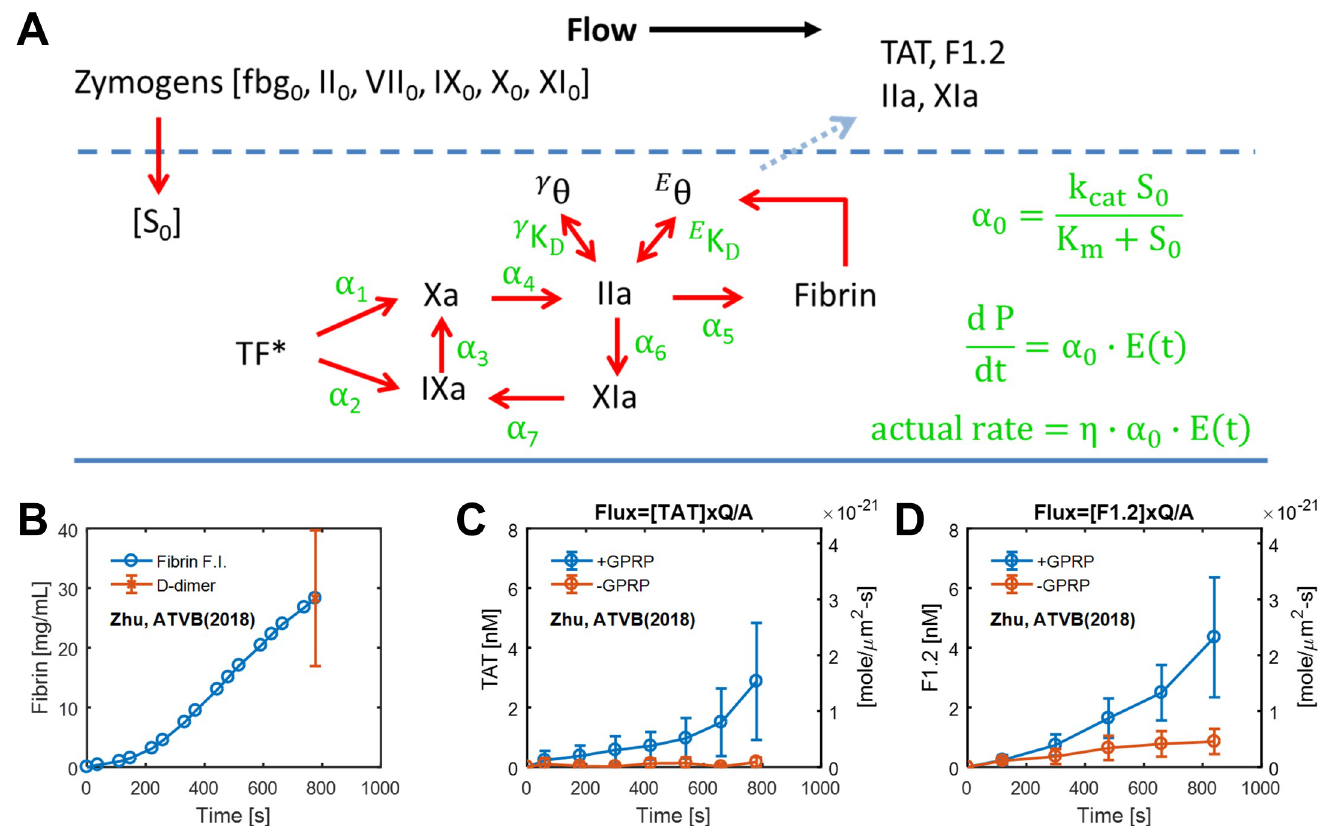
Fig 1. Schematic of the reduced model. With 7 reactions, only the activated proteases are shown (A). All zymogens were assumed to enter the clot core by diffusion to maintain their plasma level [S] o . All active enzymes had a 1-minute half-life, with TF � set to 3 min. Elution rate from the core was set to 2-sec half-life. The dynamic of fibrin from 8-channel device of the fibrin fluorescence intensity with the end-point concentration determined by D-dimer ELISA (B). Thrombin flux from the collagen/TF surface determined by thrombin-antithrombin complex (TAT) ELISA with and without GPRP to allow fibrin formation (C). Thrombin flux from the collagen/TF surface determined by fragment F1.2 ELISA with and without GPRP to allow fibrin formation (D).